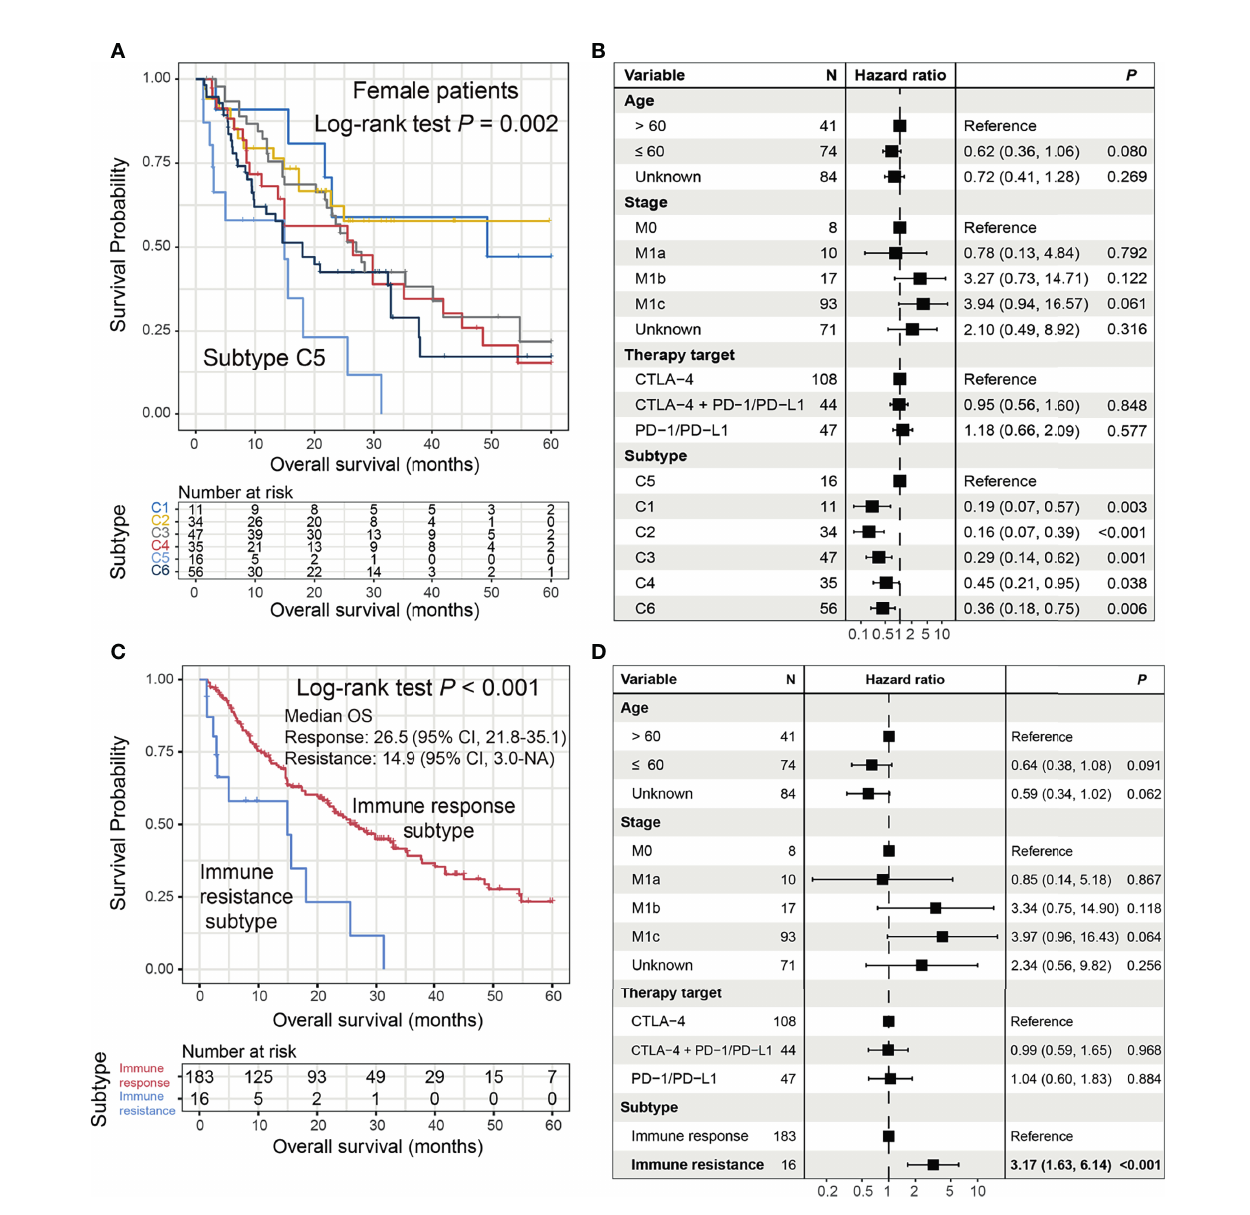
FIGURE 5 | Identi fi cation of an ICI resistance subtype in female patients. (A) Kaplan – Meier survival curves strati fi ed by the identi fi ed six clusters. (B) Forest representation of the association of the six clusters with ICI survival outcome. (C) Kaplan – Meier survival analysis and (D) multivariate Cox regression model of the de fi ned “ immune resistance ” and “ immune response ”